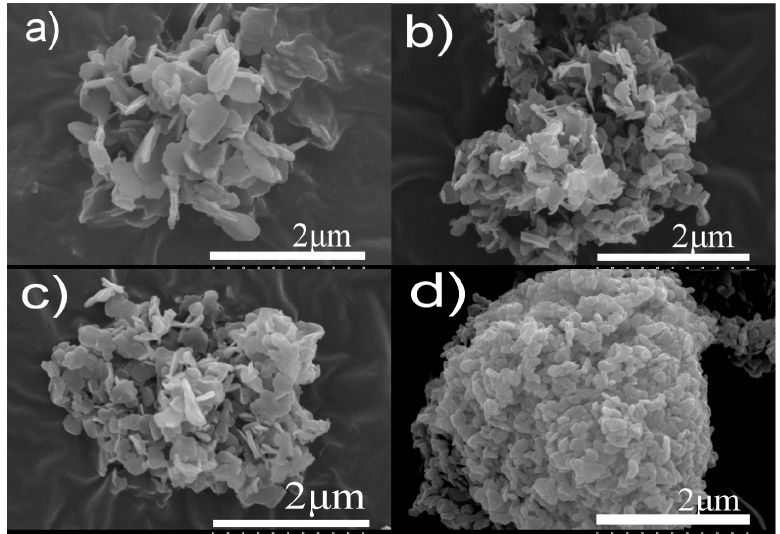
Figure 4. SEM micrographs of VPO precursors prepared with the alkoxide method and